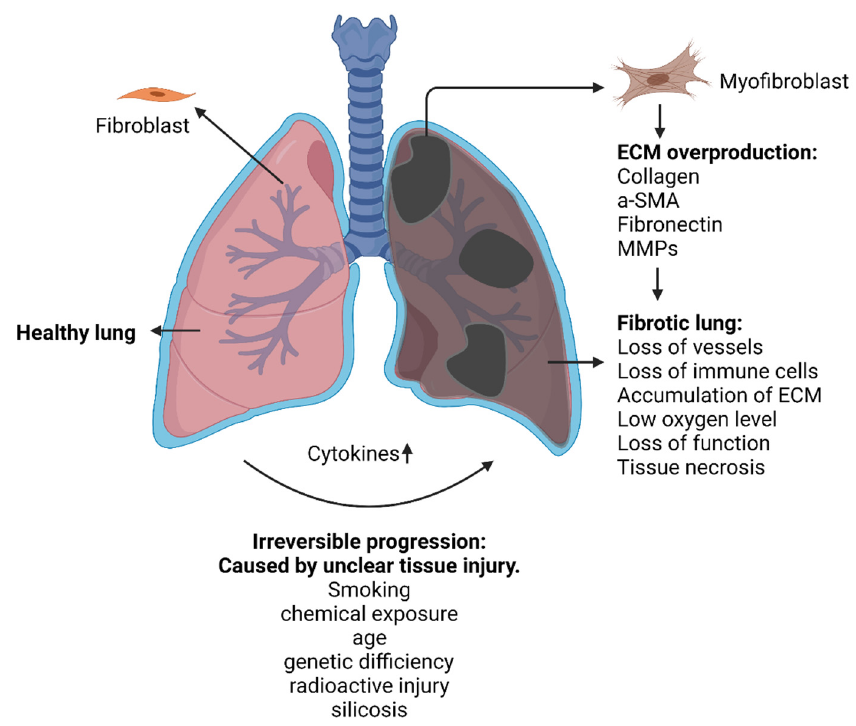
Figure 2. An illustration of extracellular matrix (ECM) overproduction in idiopathic pulmonary fibrosis fibrosis (IPF).